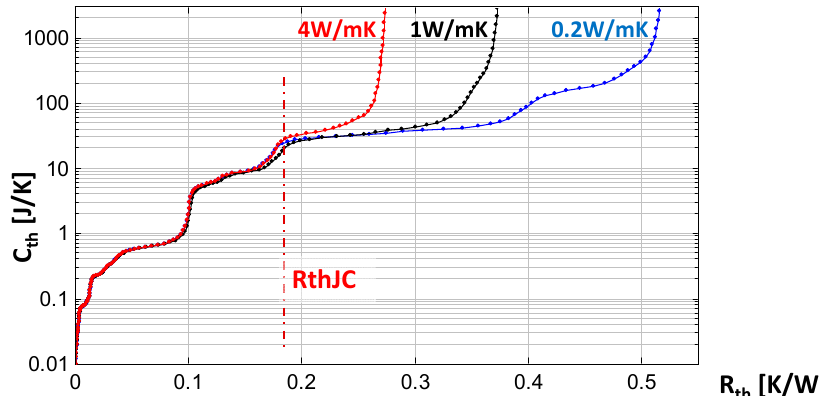
Figure 8. Foster- ( a ) and Cauer- ( b ) type representations of a 3D thermal RC net (based on Reference [4]).